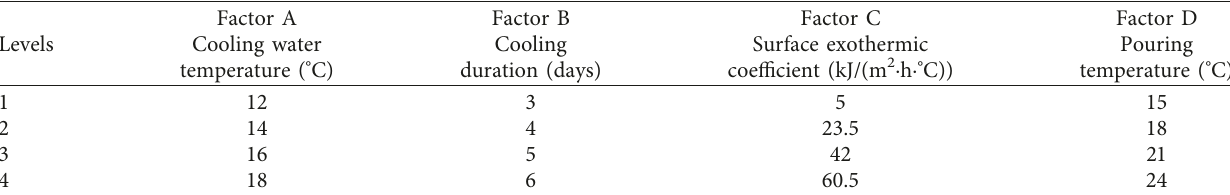
Table 2: Temperature-control parameters for the 4 factors and 4